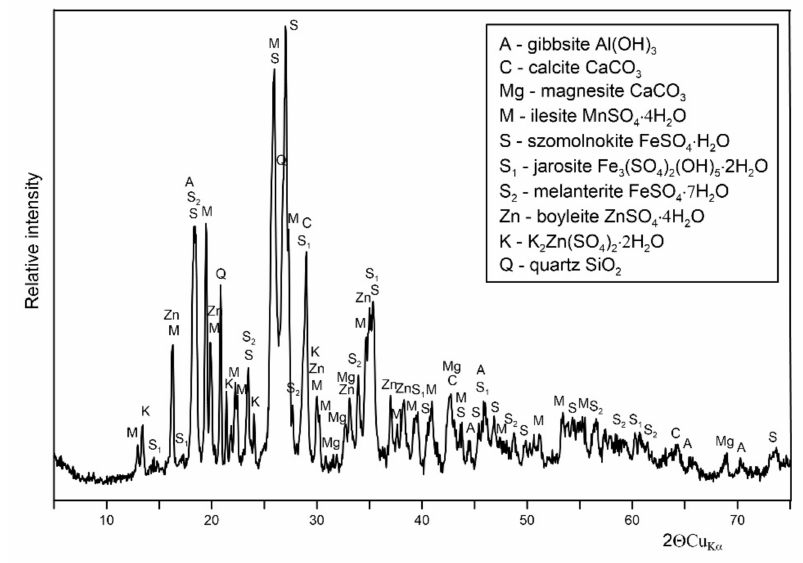
Figure 7. X-ray di ff raction pattern of the sediment formed after mixing AMD and flotation